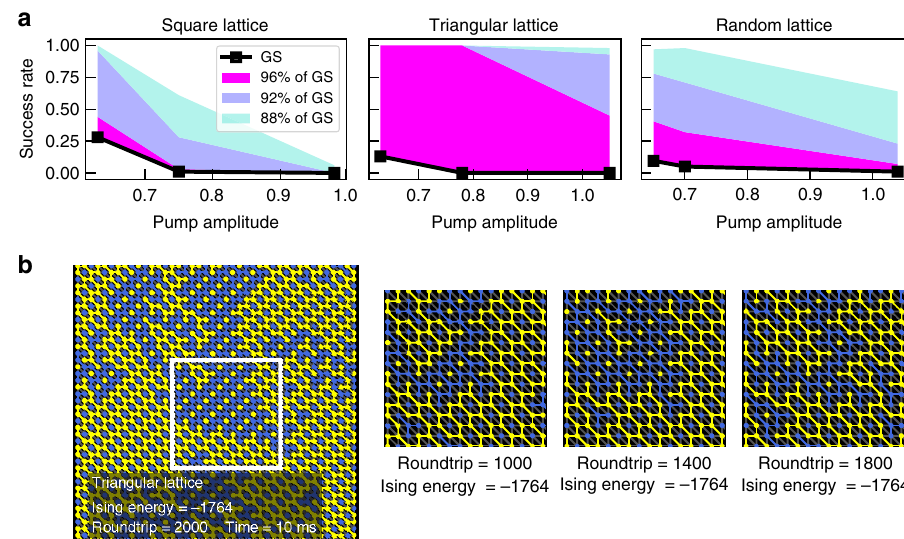
Fig. 6 Pump amplitude scaling of success rate and degenerate ground states. a Scaling of the success rate with the pump amplitude for all three graph structures. The different colors for the success rate indicate the frequency of cases where 96% (magenta), 92% (blue) and 88% (turquoise) of the ground state energy was reached. b Snapshot and close ups of a successful ground state search in the triangular lattice. Blue and yellow circles show when spins are in the up and down con fi guration (blue: down, yellow: up). Blue and yellow links indicate frustrations in the lattice due to competing spin interactions, whereas gray links show cases where neighboring spins have different signs. As the calculation progresses, a jumping between different degenerate ground states can be